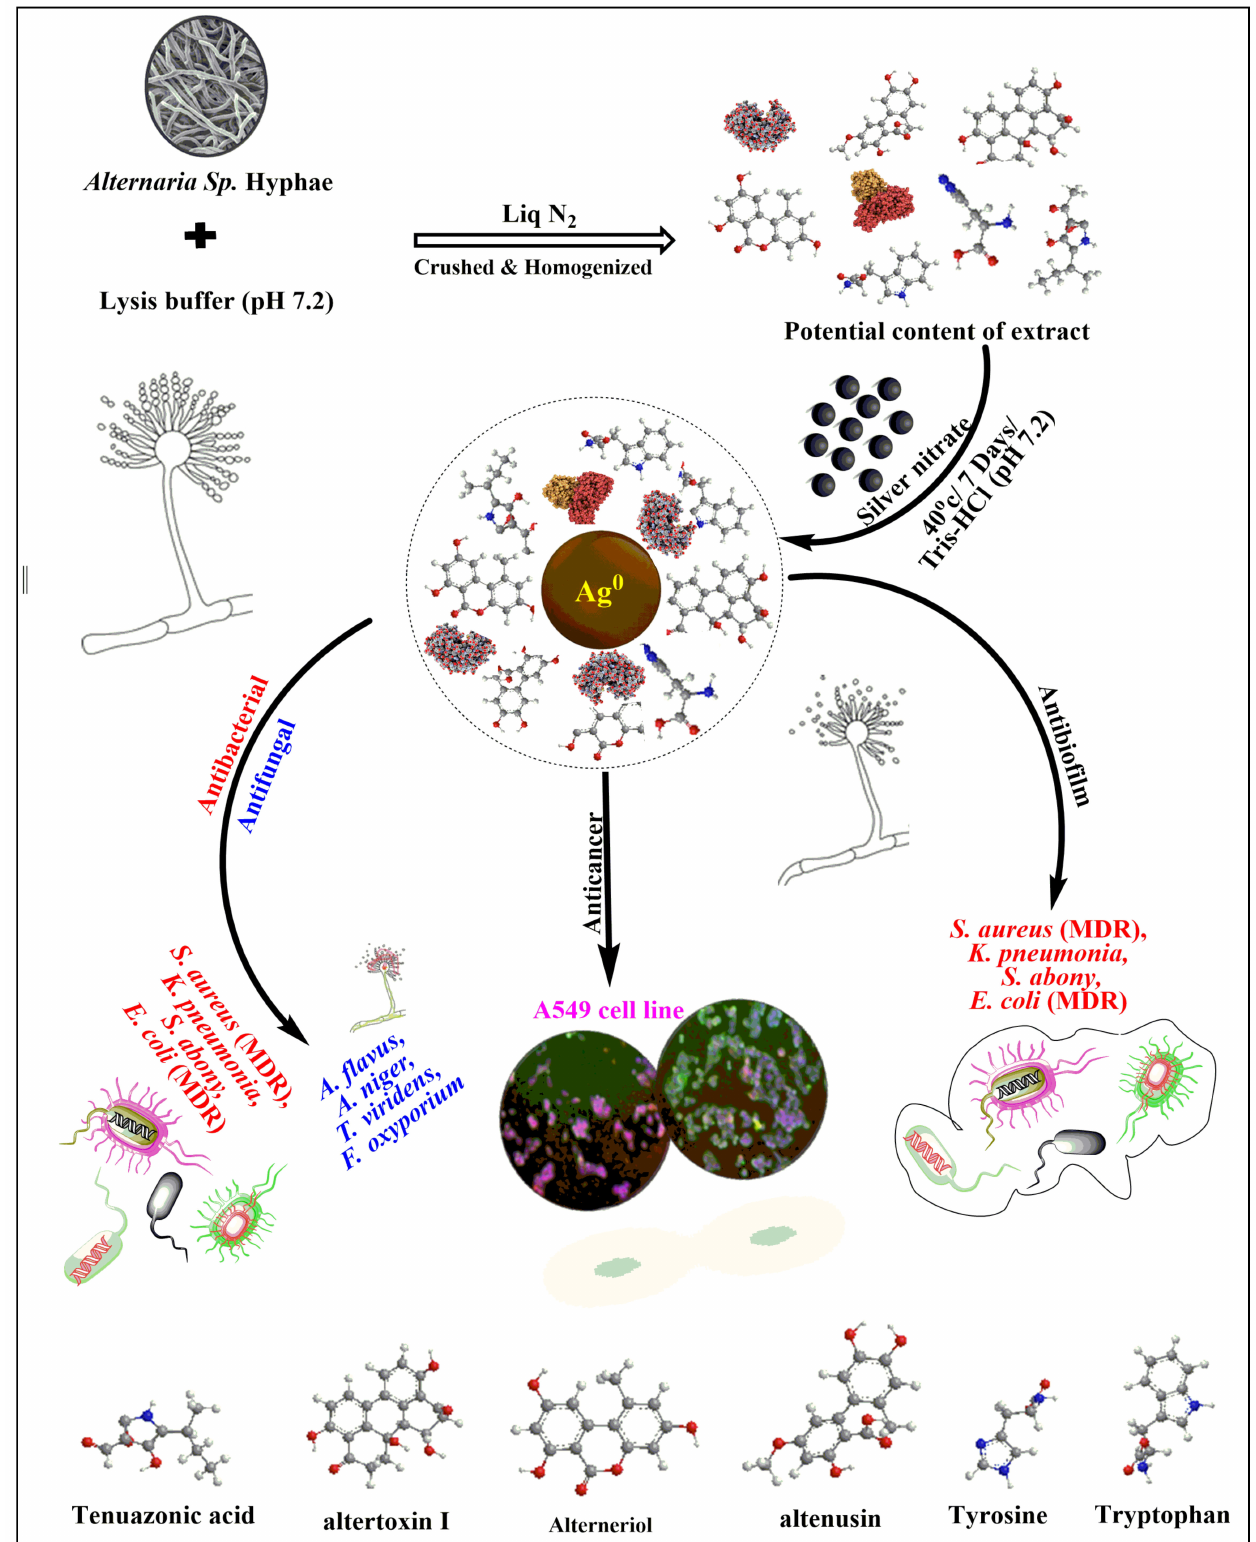
Figure 8. Schematic representation of F-AgNPs’ synthesis and their antibacterial, antifungal, anticancer, and antibiofilm